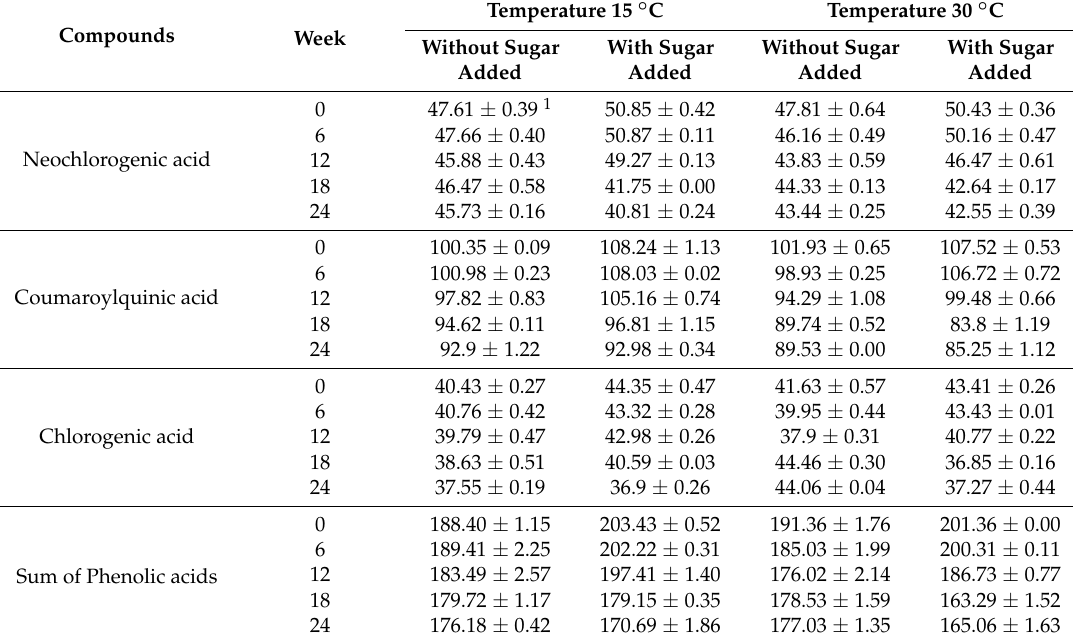
Table 1. Changes in phenolic acids content ( µ g/mL) during cherry liqueurs storage. Temperature 15 ◦ C Temperature 30 ◦ C Week